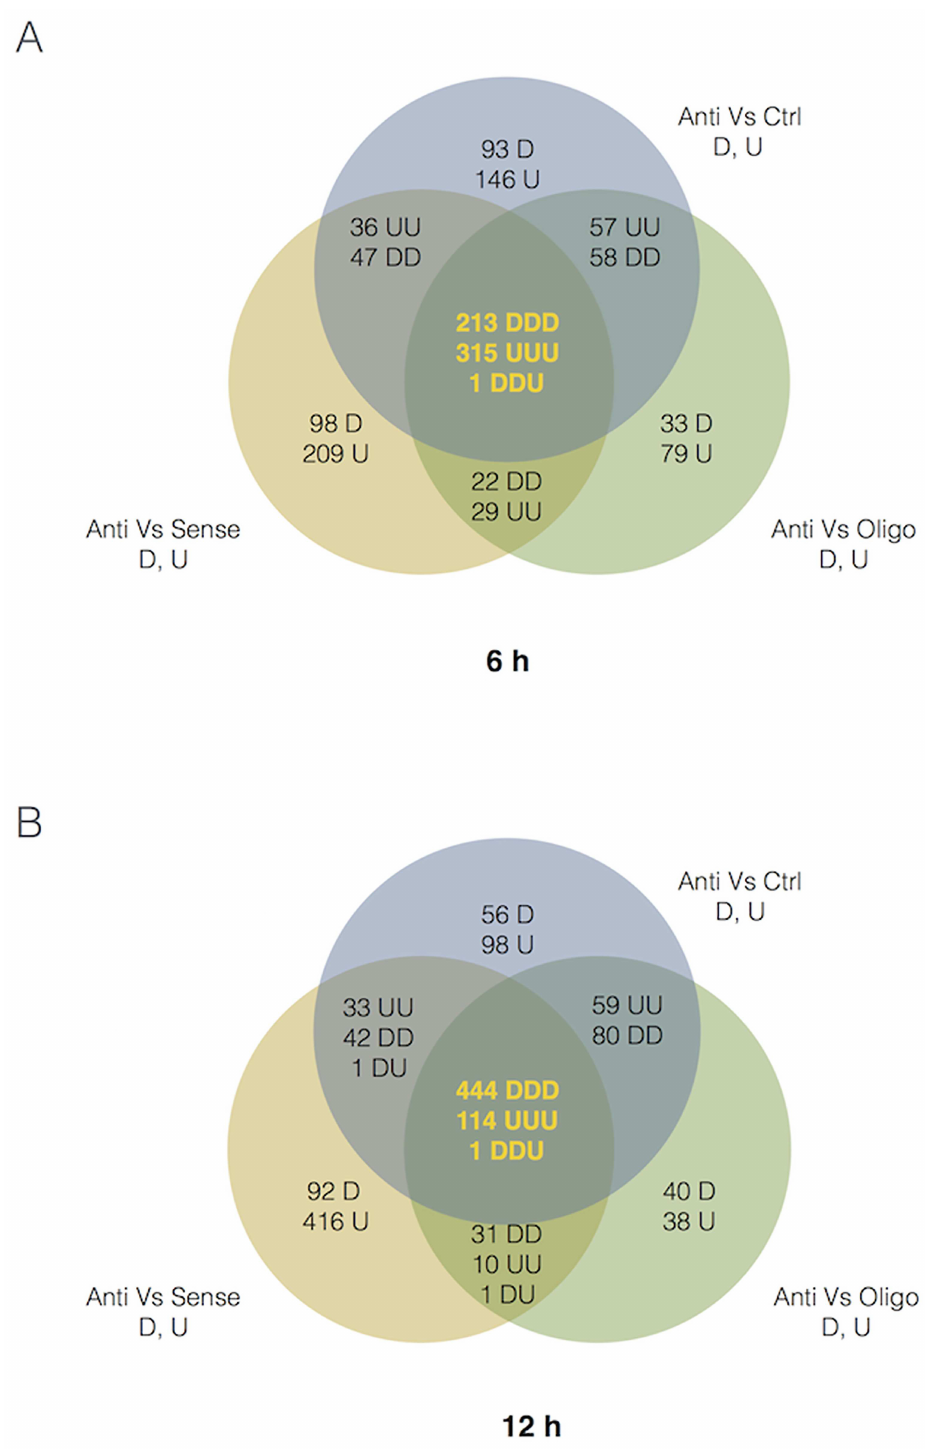
Fig 2. Venn diagrams showing pair-wise comparison between ASO and CTRL, ASO and OLF, finally ASO and SO at 6h and 12h. For intersections letters are in clockwiseorder of, for exampleDD for {Anti vs Ctrl} Intersect {Anti vs Oligo} means first D in {Anti vs Ctrl} and second D in {Anti vs Oligo}. Concerning the central intersection(yellownumbers) the clockwiseorder starts from Anti vs Ctrl. D means down-regulated and U